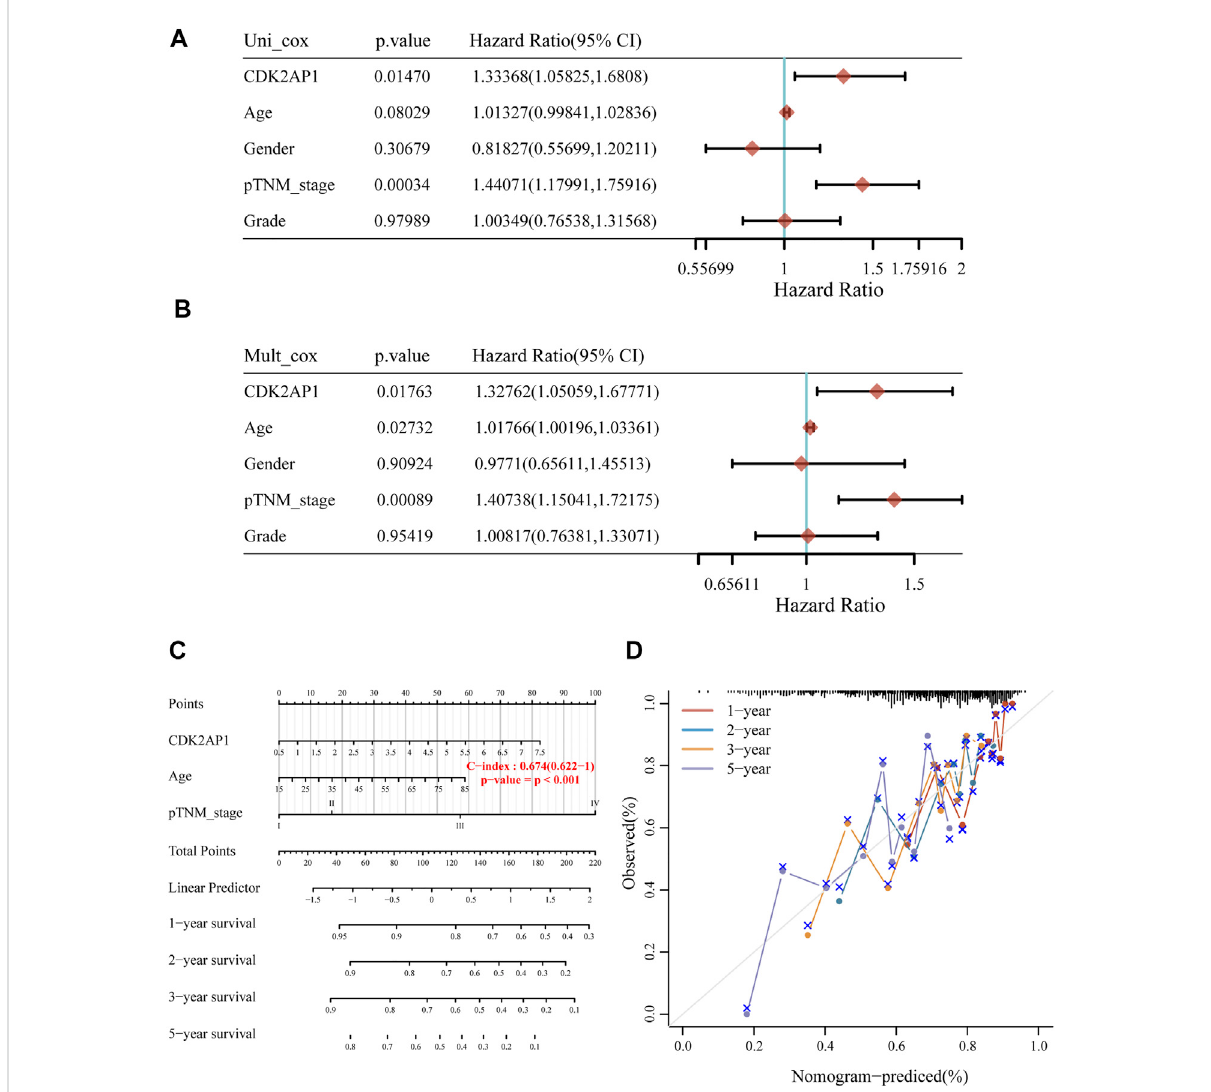
FIGURE 2 ConstructionofLIHCprognosticmodel (A) UnivariateCoxanalysisoftheriskfactorsrelatedwithsurvivalofLIHC (B) MultivariateCoxregression analysisoftheriskfactorsrelatedwithsurvivalofLIHC (C) ThenomogrammodelcanpredicttheprognosisofHCCpatients (D) Thecalibrationcurves of the overall survival nomogram model. An ideal nomogram is represented by the dashed diagonal line, while the 1-year, 2-years, 3-years and 5- years observed nomograms are illustrated by the red, blue, orange and purple